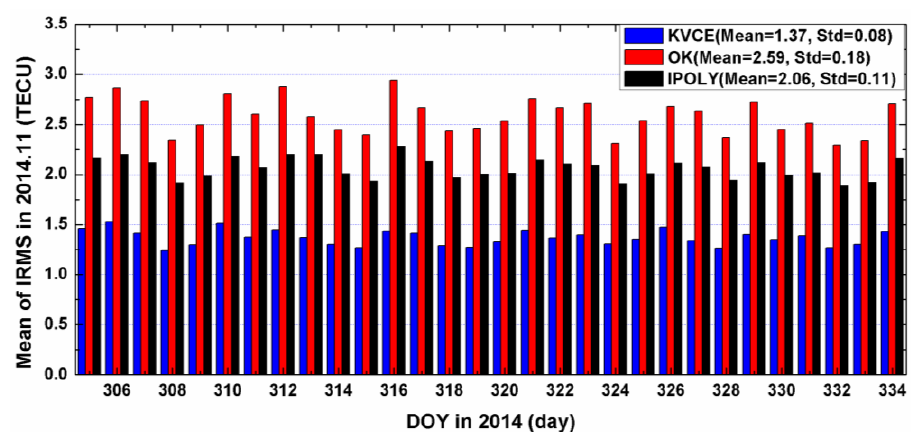
Figure 6. The IRMS of KVCE, OK and IPOLY in 2014.11.